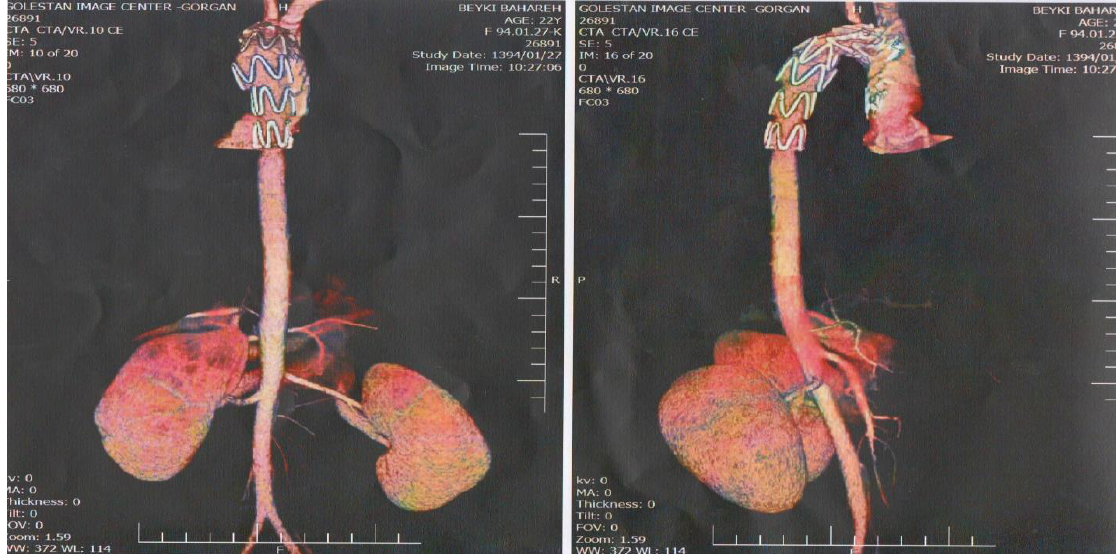
Figure 1. Computed tomography angiography, successful implantation of a Zenith Tx2 TAA endovascular stent graft in December 2014, which was very patent in follow-up imaging in April 2015 .